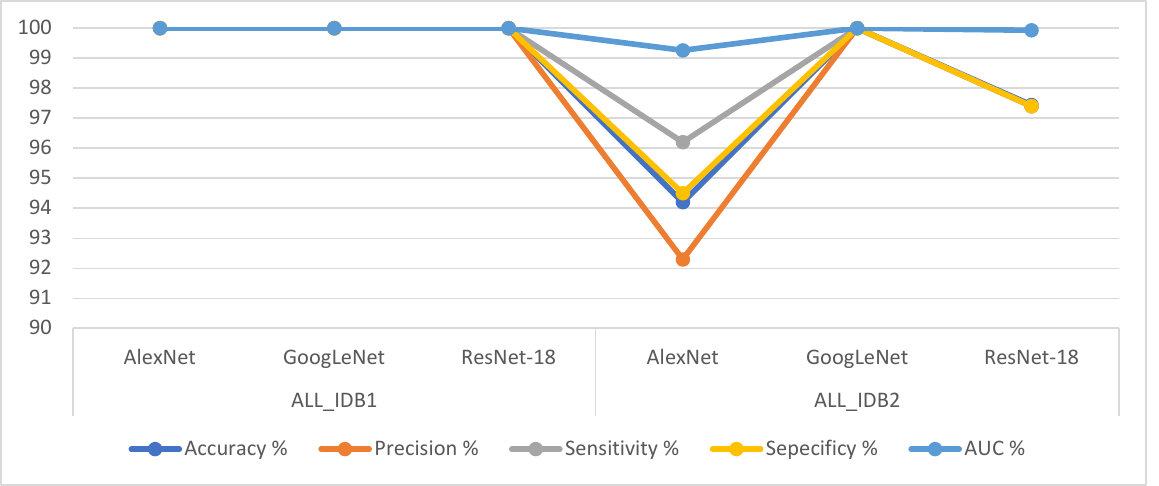
Figure 21. Performances of all the convolutional neural network models for the ALL_IDB1 and ALL_IDB2 datasets.